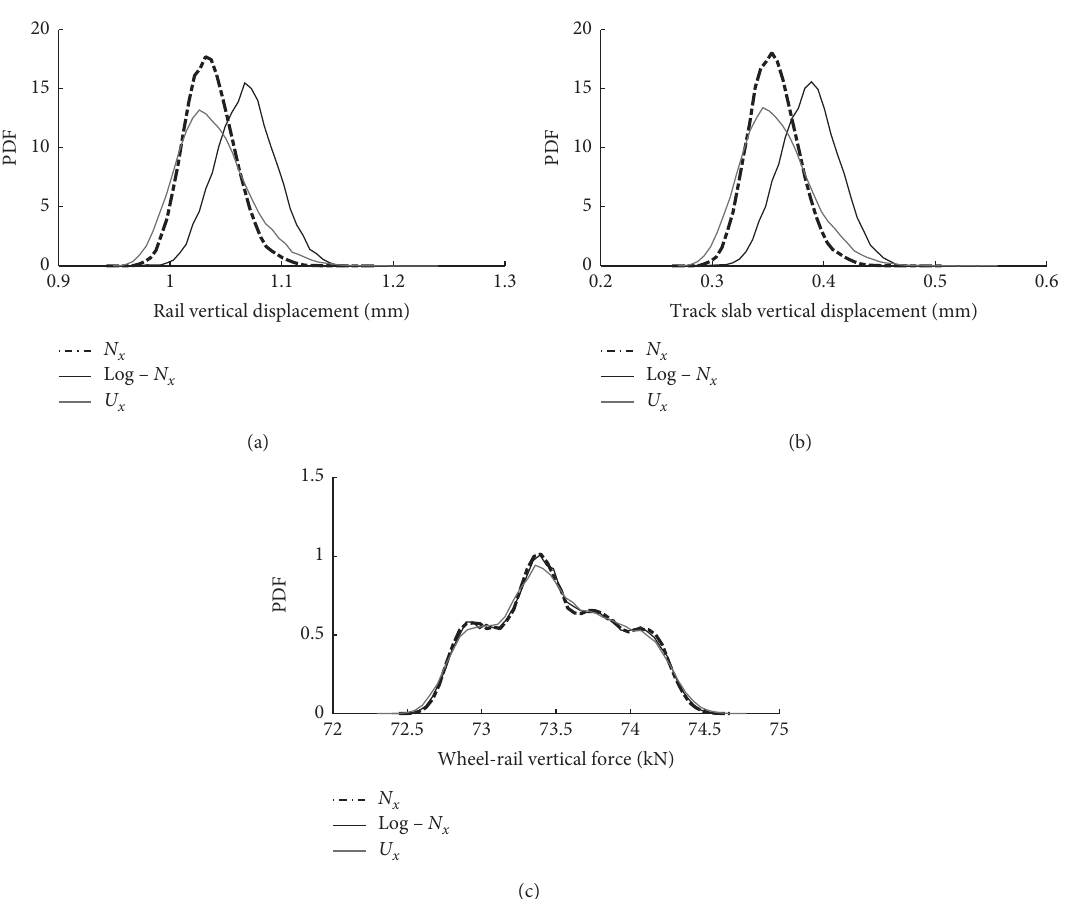
Figure 11: The PDF of dynamic responses due to the nonuniformity of vertical stiffness of CAM. (a) Rail vertical displacement (mm); (b) track-slab vertical displacement (mm); (c) wheel-rail vertical force (kN).